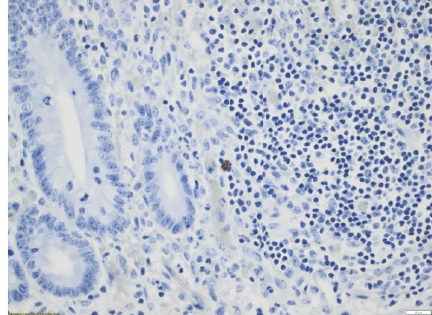
Figure 1: Positive result of immunostaining for varicella zoster virus (VZV) in mucosa [ × 40].